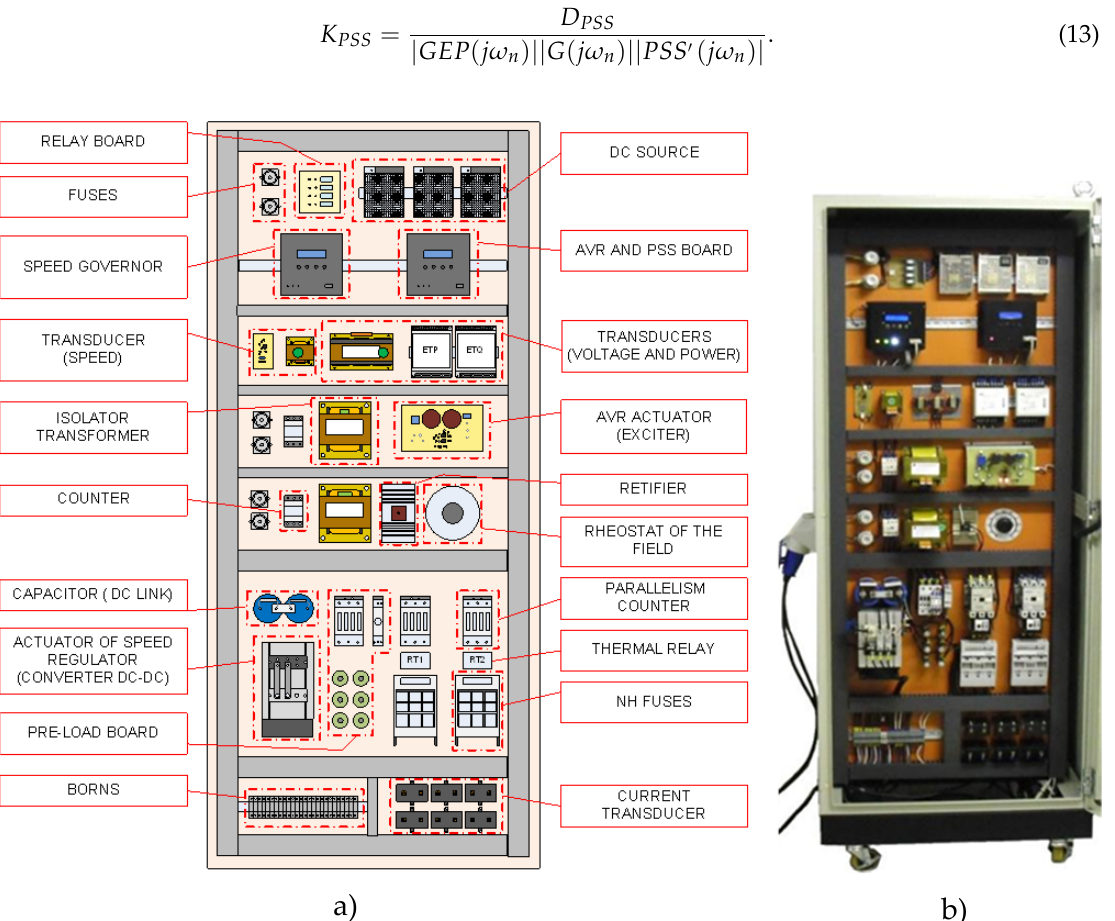
Figure 3. AVR and PSS man – machine interface. 4.3. System Identification Tests